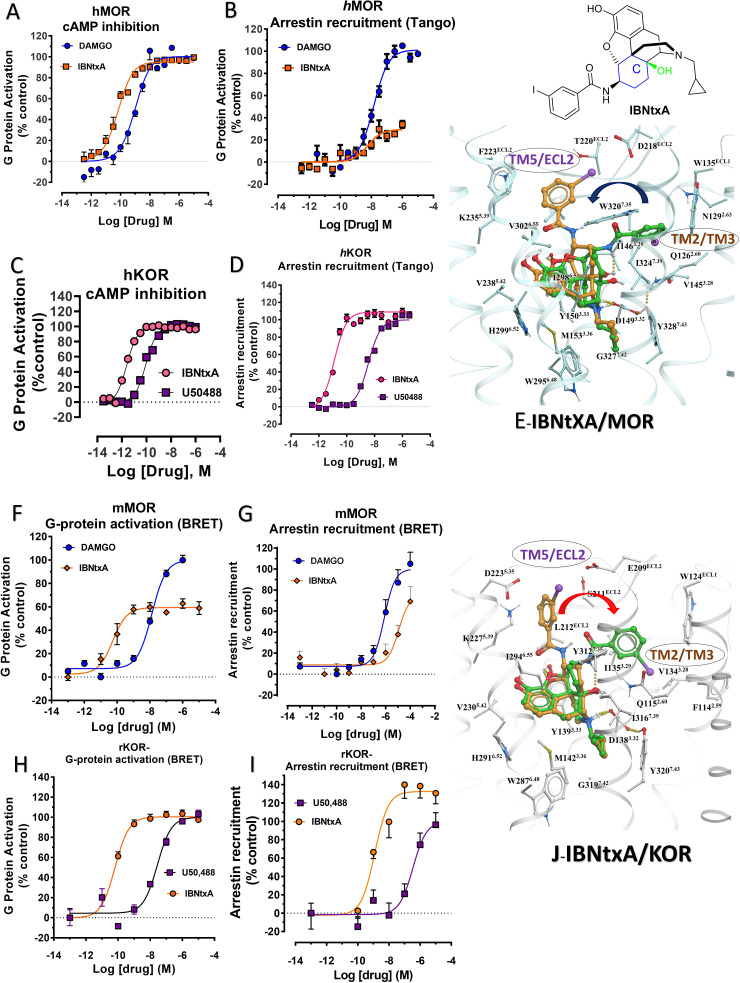
IBNtxA is arrestin biased at KOR but shows G protein biased agonism at MOR.(A–B) At hMOR, IBNtxA (orange) is a G protein biased agonist compared with DAMGO (blue) (N = 4). (C–D) At hKOR, IBNtxA (pink) is a full agonist in cAMP inhibition (N = 3) and Tango-arrestin recruitment assays (N = 3) compared to U50,488H (purple). (F–G) However, at mMOR, it is a partial agonist in G-signaling assays (N = 4) and shows reduced arrestin potency (N = 4) compared to DAMGO (blue) in BRET assays. (H–I) In BRET assays using rKOR, IBNtxA is a full agonist in both G-signaling (N = 3) and arrestin signaling assays (N = 3) compared with U50,488H (purple). (E and J) The docking poses of IBNtxA (chair form, orange stick) and (boat form, green stick) at an active state of MOR and KOR are shown. At MOR, the saturated ring C in IBNtxA leads to interaction of the ligand in the ECL2 and TM5 region leading to a preference of chair form shown by a red arrow. At KOR, the iodophenylamido moiety of IBNtxA aligns in the hydrophobic pocket between TM2 and TM3 in KOR, a cavity lined with V1182.63, W124ECL1 and L1353.29 similar to MP1202. This flip of ring C conformation from chair to boat is shown by a blue arrow. Preference for chair form correlates with G protein bias while preference for boat form correlates with increased arrestin signaling or no preference for any pathway. See Appendix 1—table 9 for values, Appendix 1—figure 4 and Appendix 1—tables 10–11 for bias calculations.